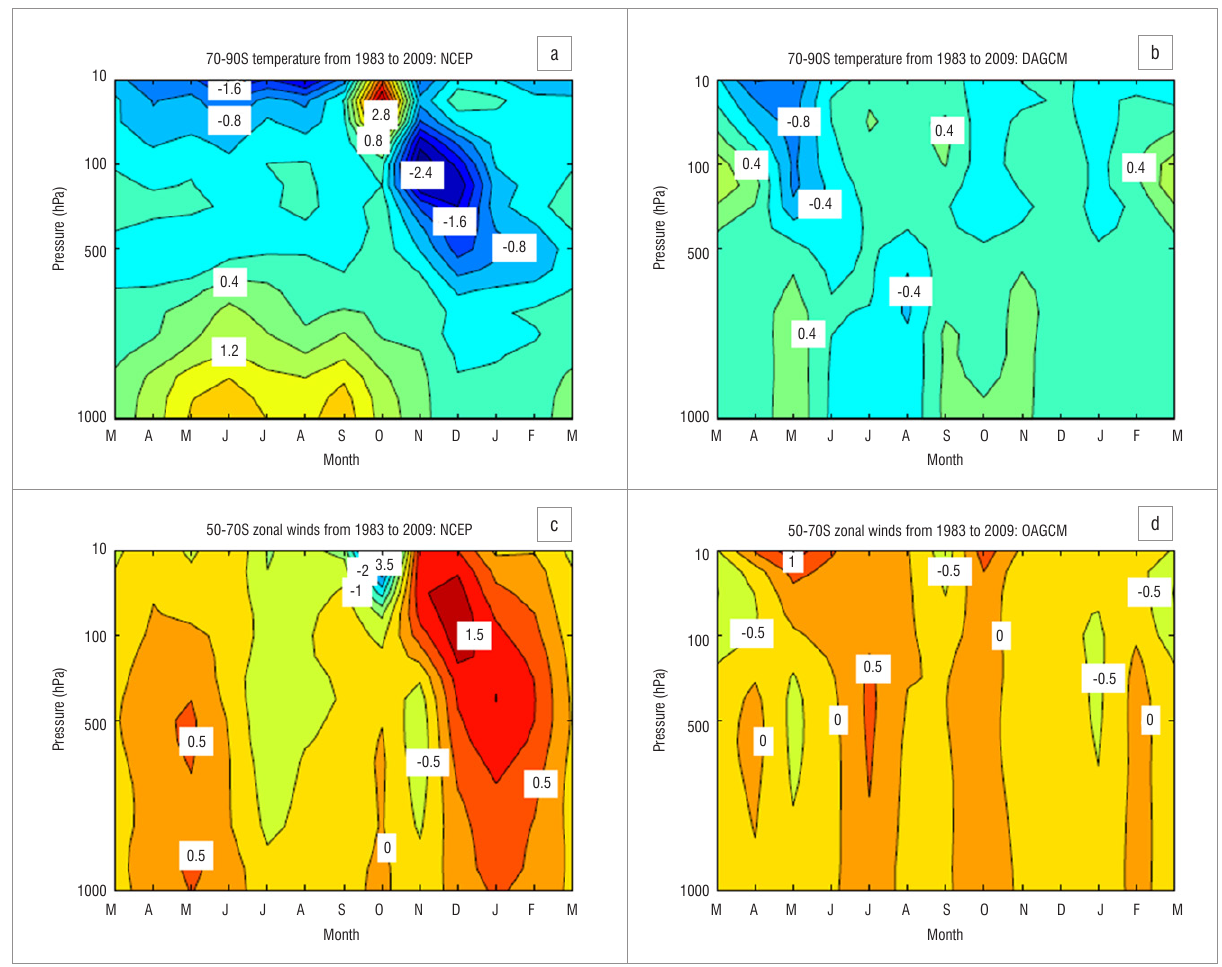
Figure 3: Linear trends in polar cap (averaged over 70–90°S) temperature measured in K/decade from 1983 to 2009 in (a) NCEP and (b) OAGCM data sets. Mid-latitude wind (averaged from 50°S to 70°S) linear trends measured in m/s/decade. The contour intervals in the top and bottom panels are 5 K/ decade and 0.2 m/s/decade,